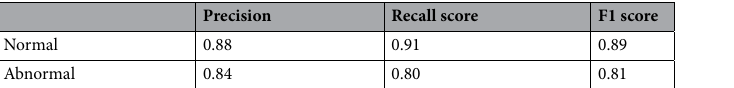
Precision Recall score F1 score Normal 0.88 0.91 0.89 Abnormal 0.84 0.80 Table 3. The averages of Precision, Recall and F1 score in discriminating normal sounds from abnormal sounds.